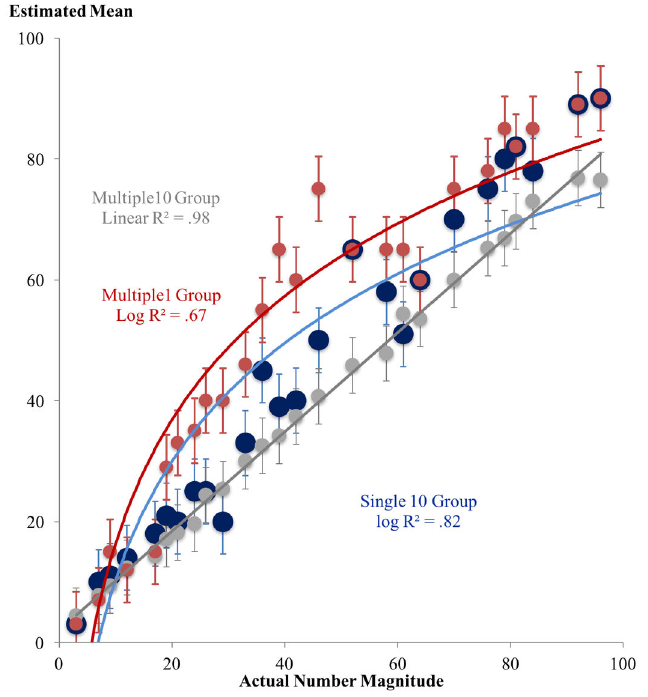
Figure 3. Range of estimation for each number at posttest by